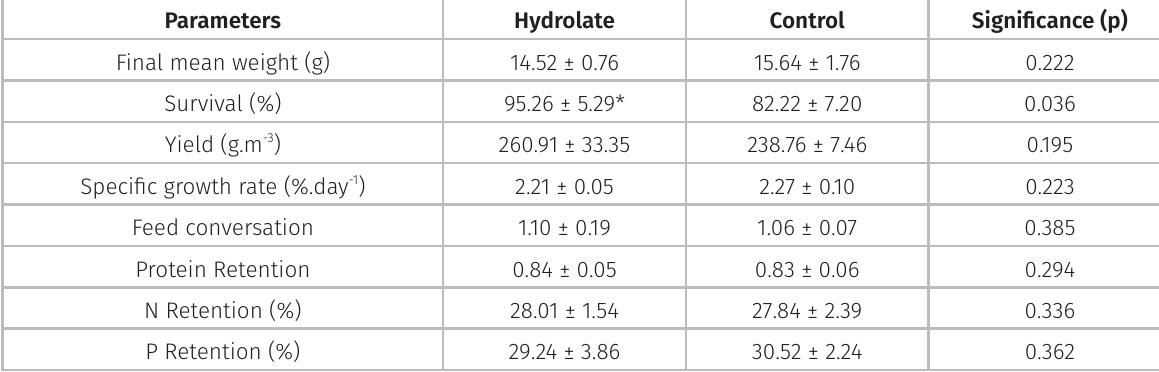
Table II. Growth performance and nutrient retention of Nile tilapia ( Oreochromis niloticus ) fed a supplemented hydrolate diet from Curcuma longa